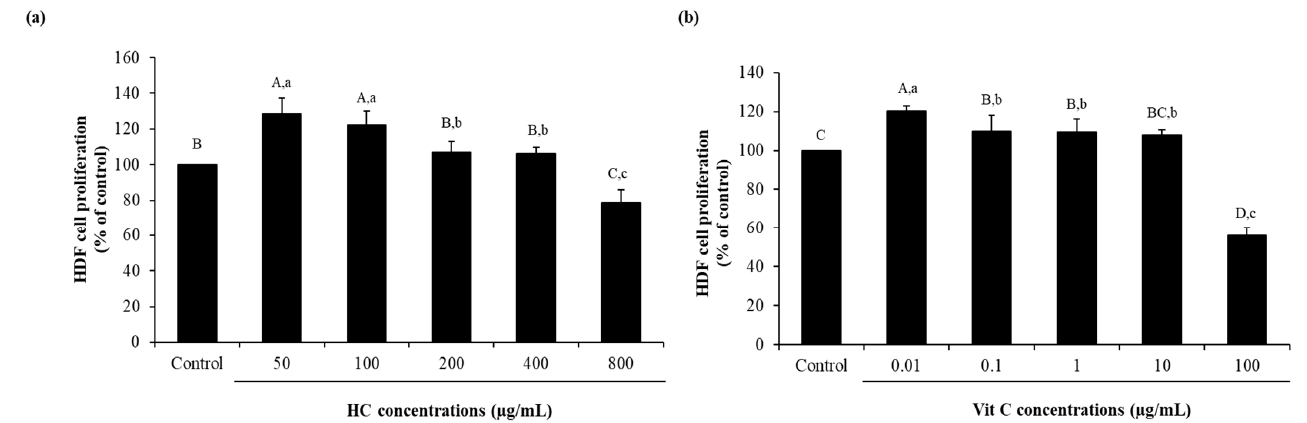
Figure 2. Effect of HC from salmon skin ( a ) and vitamin C (Vit C) ( b ) at different levels on the proliferation of human dermal fibroblast (HDF) cells. Bars represent standard deviation ( n = 3). Different uppercase letters on bars indicate significant differences between different samples tested and control ( p < 0.05). Different lowercase letters on bars indicate significant differences among samples tested with HC or Vit C at different concentrations ( p < 0.05).